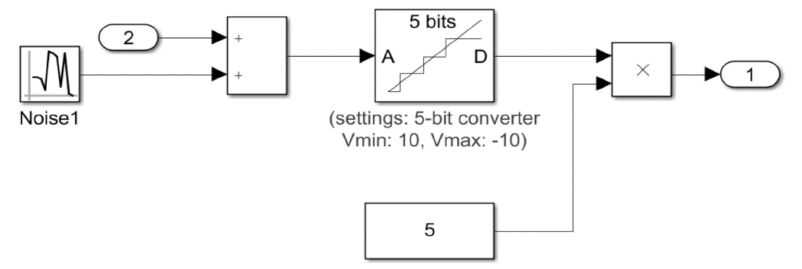
Figure 3. Voltages sensor